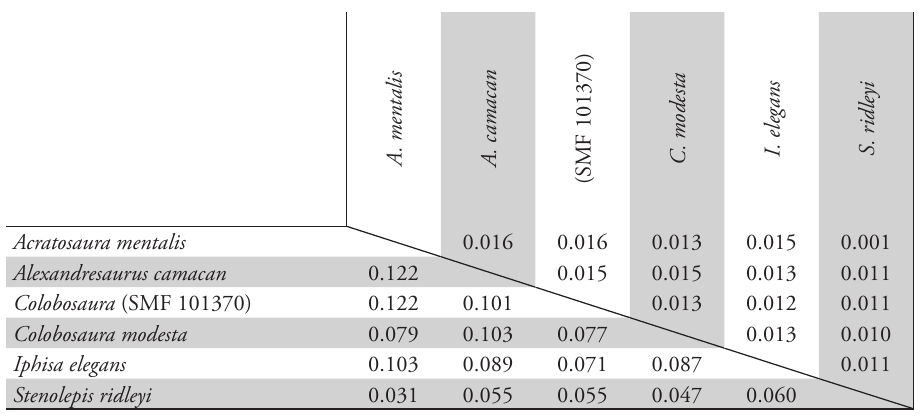
Figure 1. Maximum Likelihood tree obtained from 16S mtDNA for the tribe Iphisini (Gymnophthal- midae). Numbers on the nodes represent the bootstrap values and numbers below branches (and scale bar at the bottom left corner) denote branch length (substitutions/site). Specimen highlighted in red indicates our sample. See Appendix 1 for details of specimens used in the analysis. Table 1. Pairwise genetic distances (lower-left diagonal), and SD (upper-right diagonal) among species of Iphisini: